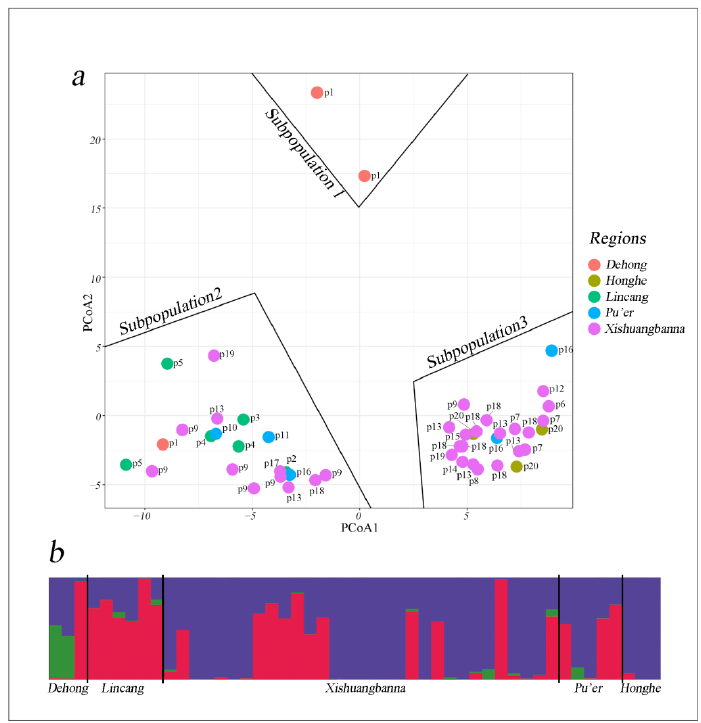
Figure 6. ( a ) Principal coordinates analysis of Eleutharrhena macrocarpa based on the genetic similarity matrix of SCoT markers; and ( b ) STRUCTURE analysis revealed that the best K is 3.